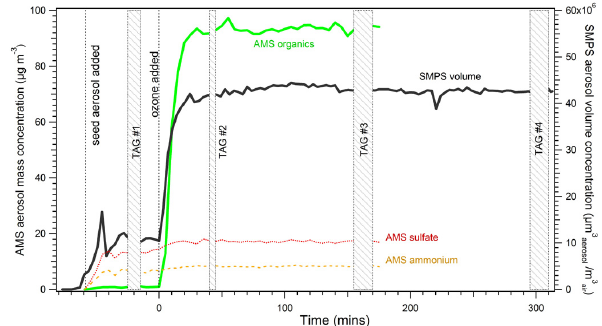
Fig. 2. Wall-loss corrected aerosol mass and volume concentrations as measured by the AMS and SMPS,